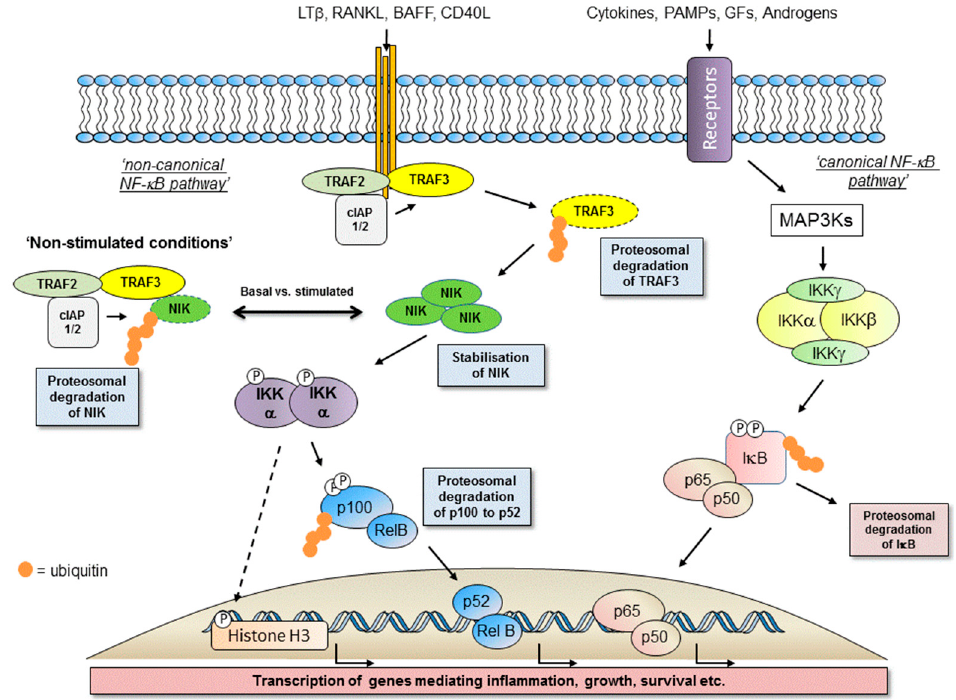
Figure 1. Schematic representation of Nuclear Factor- κ B (NF- κ B)-inducing kinase (NIK)-inhibitory- κ B kinase (IKK) α and IKK β -mediated cell signalling encompassing the non-canonical NF- κ B cascade, canonical NF- κ B cascade and potential IKK α -dependent, NF- κ B-independent pathways (e.g., by the dashed line).